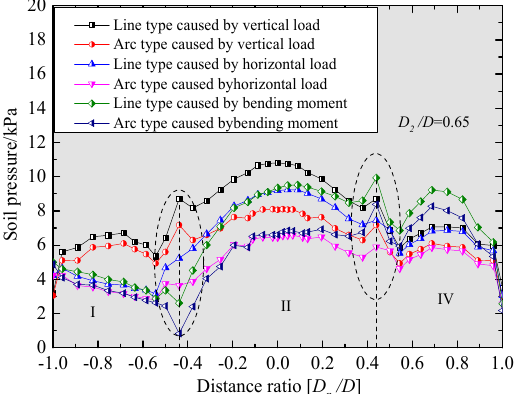
Figure 10. Top-cover soil pressure with monotonic load.